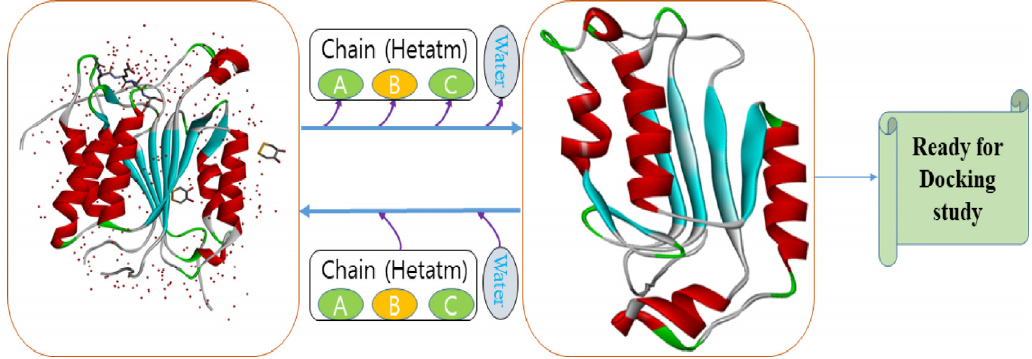
Figure 6. 3D structure preparation of human caspase 8 for molecular docking analysis.